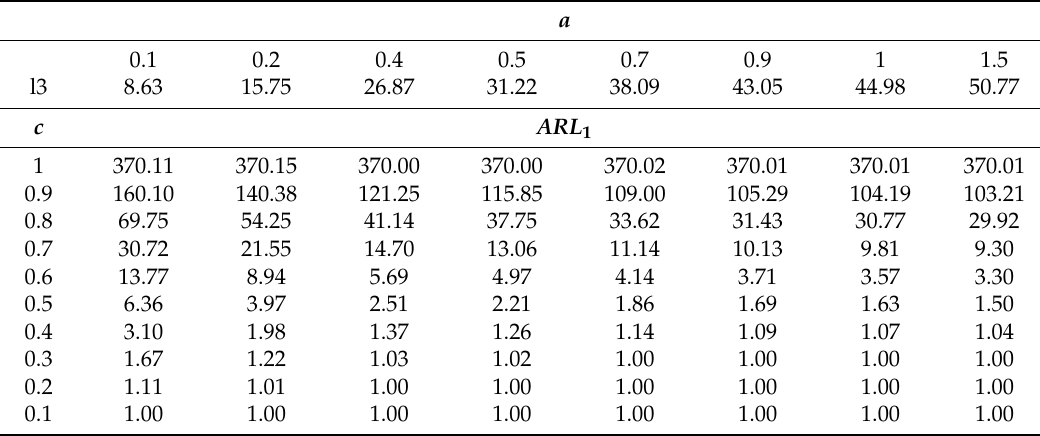
Table 4. The values of ARLs when r 0 = 370, β = 1, and µ 0 =